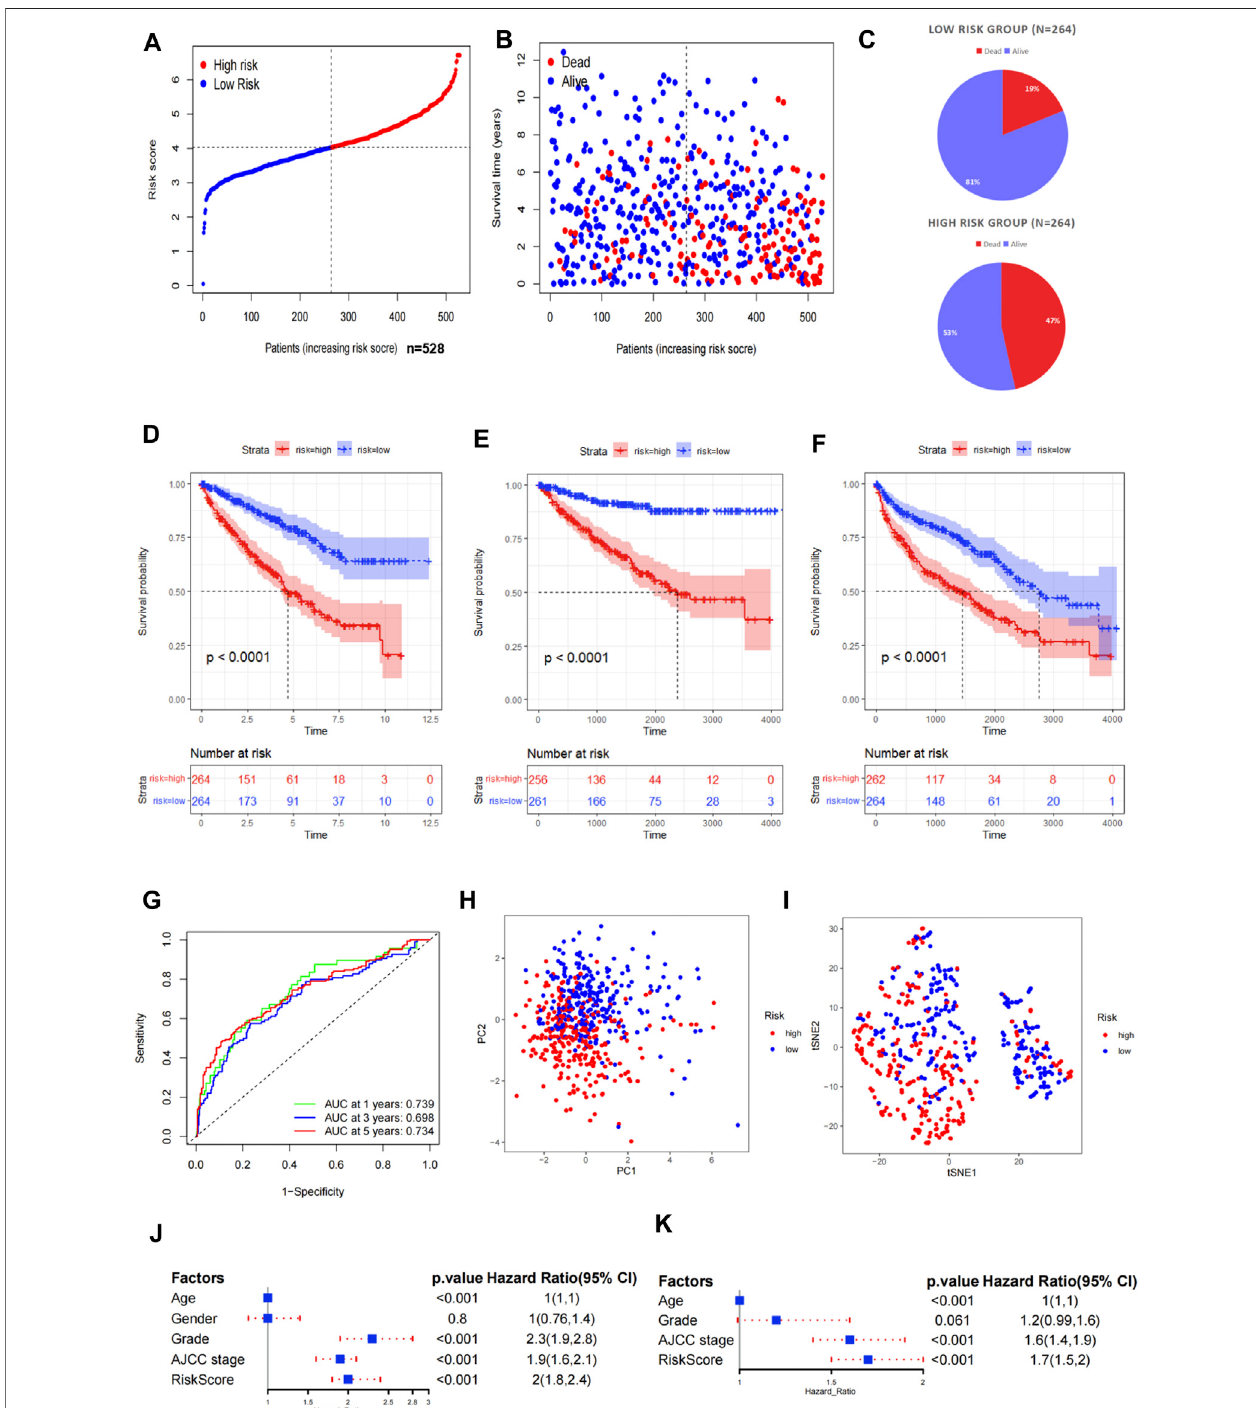
FIGURE2 | Evaluation ofthe prognostic signature inTCGA. (A) Distribution ofthe riskscores inthe low- and high-riskgroups. (B,C) Patient distribution in thelow- and high-risk groups based on the survival status. (D – F) Overall survival (OS), disease-speci fi c survival (DSS), and progress-free survival (PFS) curves strati fi ed by the low- and high-risk groups. (G) Time-dependent ROC curves for OS prediction by the ASRG-based signature. (H,I) Two risk groups were distinguished by the principal componentanalysis(PCA)andt-distributedstochasticneighborembedding(t-SNE). (J,K) UnivariateandmultivariateCoxregressionanalysesofthesignatureand other clinical